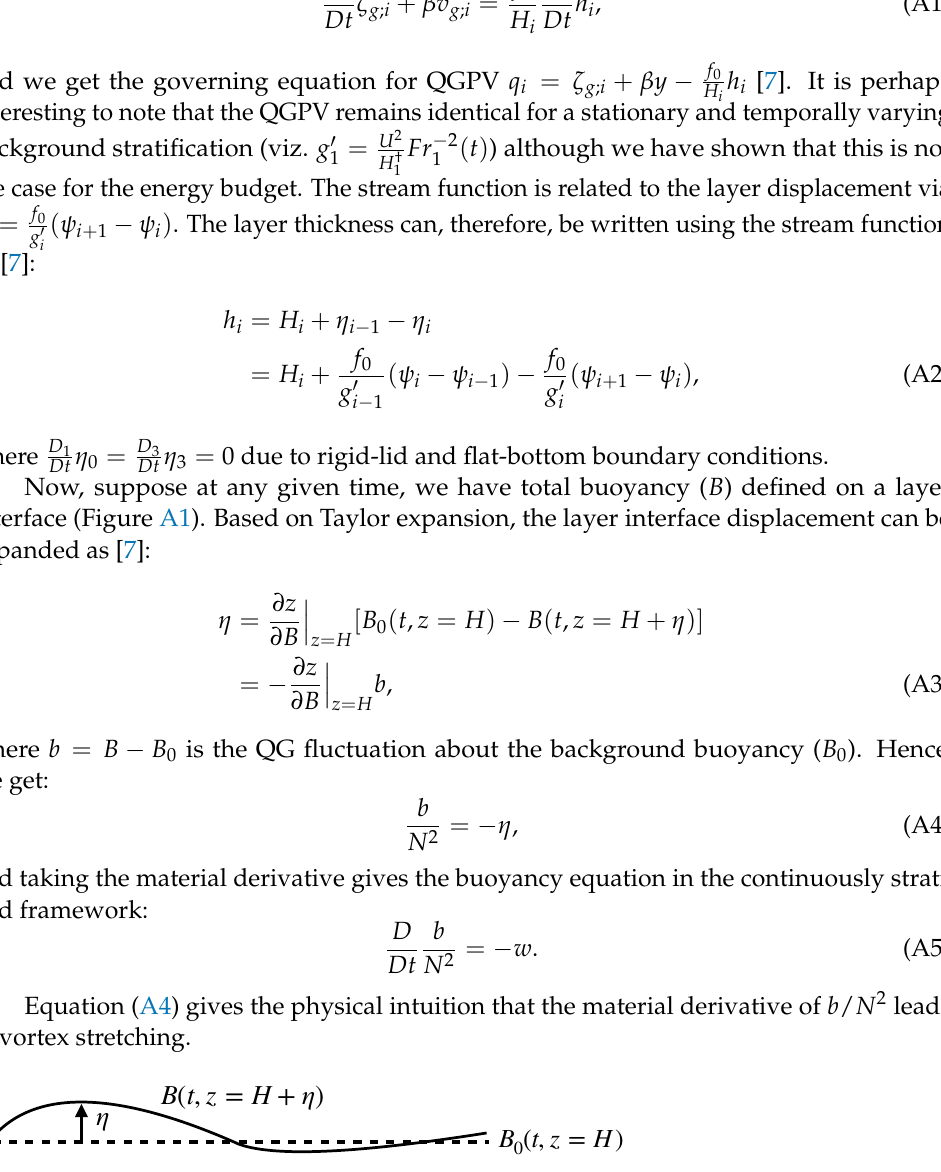
Figure A1. Schematic of a relation between buoyancy ( B ) and layer interface displacement ( η ). The background buoyancy is B 0 defined at z = H